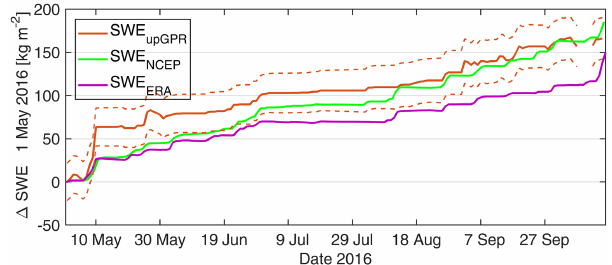
Figure 7. Seasonal changes in accumulation in respect to 1 May 2016. We compare upGPR derived changes in SWE (brown line with uncertainty range indicated by dashed lines) with simu- lated variations by MAR for both forcings (green line – NCEP1 forcing; purple line – ERA-Interim forcing).